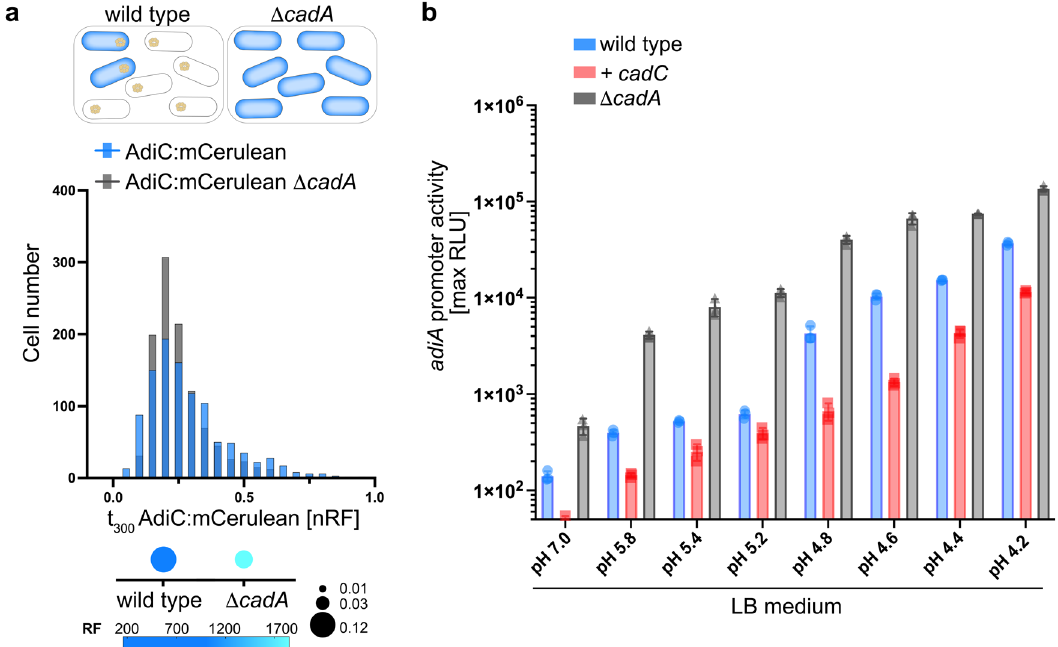
Fig. 6 Manipulation of intracellular stress resistance by either eliminating ( Δ cadA ) or increasing ( + cadC ) the activity of the Cad system affects the degree of heterogeneity and pH-dependent induction of the Adi system. a Normalized RF values of cells expressing AdiC:mCerulean in the E. coli wild type background (blue) or the cadA mutant (gray). Cells were monitored after growth at pH 4.4 in LB medium at t 300 . On top of the histogram, the cells are shown in a schematic overview, with blue cells representing the AdiC:mCerulean ON state and yellow dots representing CadA. Below the histogram, the noise (standard deviation/mean of log-transformed values) is presented by the size of the dots (the higher the noise, the larger the size of the dot), and the average RF is represented by a blue color (the more intense the blue, the higher the average relative fl uorescence intensity). RF was quanti fi ed using the MicrobeJ plugin of the ImageJ software of the fl uorescent microscopic images for 1000 cells per condition. The calculated mean RF and noise values are summarized in Supplementary Table 1. nRF normalized RF values. b E. coli MG1655 wild type and the cadA mutant (each transformed with the plasmid pBBR1-MCS5-P adiA - lux ) were grown in MM at pH 5.8 supplemented with 10 mM lysine and then shifted to LB medium of the indicated pH values. Luminescence and growth were determined every 10 min in microtiter plates with a Tecan In fi nite F500 system (Tecan, Crailsheim, Germany). Data are reported as relative light units (RLUs) in counts per second per milliliter per OD 600 , and maximal RLU at 1.9 h is shown. All experiments were performed three times ( n = 3), and error bars represent standard deviation of the means. Growth over 10 h is presented in Supplementary Fig. 3 at selected pH values. LB lysogeny broth, MM minimal medium, RF relative fl uorescence